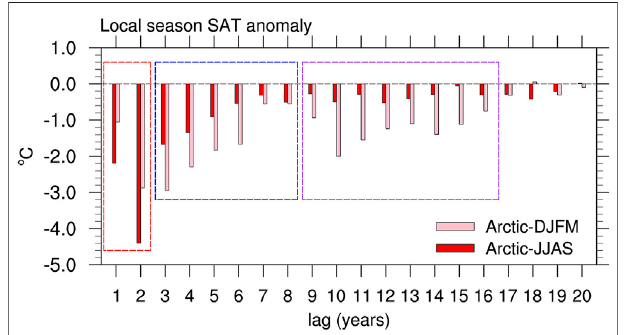
FIGURE 2 | Surface air temperature (SAT) anomalies in summer (JJAS, red bar) and winter (DJFM, pink bar) over the Arctic after the Samalas mega volcanic eruption. Lag (1) represents the fi rst summer and winter after the eruption. The red, blue, and purple dashed box represents Period-1 (P1), Period-2 (P2), and Period-3 (P3),